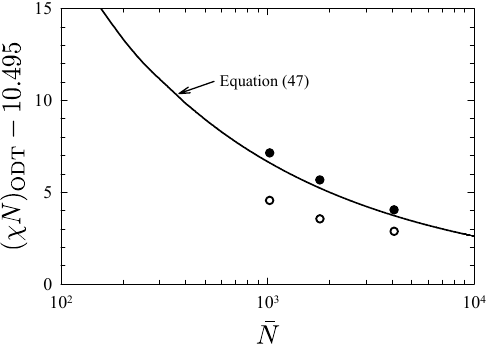
Figure 4. Fluctuation correction to the ODT of symmetric diblock copolymers. The open and closed symbols are based on the linear, χ = z ∞ χ b , and nonlinear, Equation (46), interaction parameters, respectively. The curve compares the universal prediction from Equation (47) [8]. Adapted from Ref.